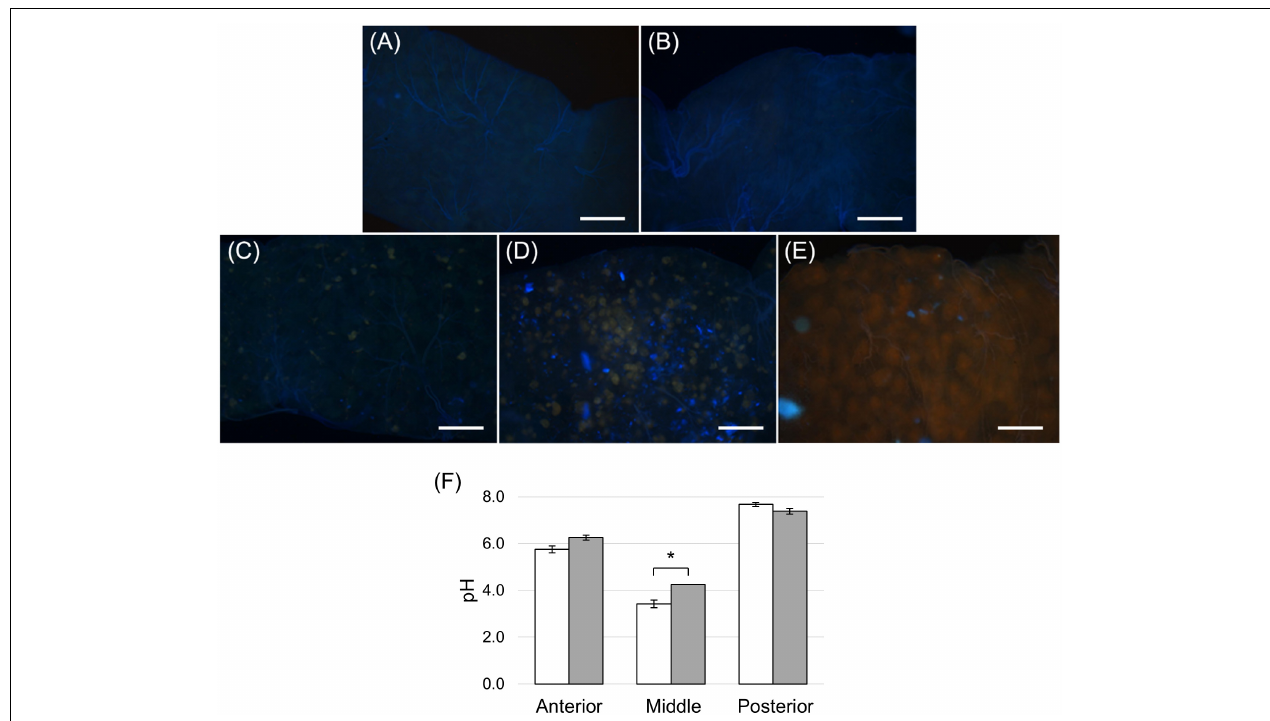
FIGURE 5 | Copper feeding experiments. (A) Dissected midgut from control larvae reared on standard diet without CuCl 2 for 24 h. (B–E) : dissected midgut from larvae reared on standard diet added with CuCl 2 for 6, 14, 24 and 48 h, respectively. (F) pH measurement of midgut juice samples from anterior, middle, and posterior regions of the midgut isolated from larvae fed for 24 h on control (white bar chart) and copper-containing diet (gray bar chart). The values are reported as mean ± SEM of at least 3 experiments. Only in the middle midgut a significant difference between groups was observed (unpaired t -test: ∗ p < 0.01). Bars: 100 µ m (A–E) .